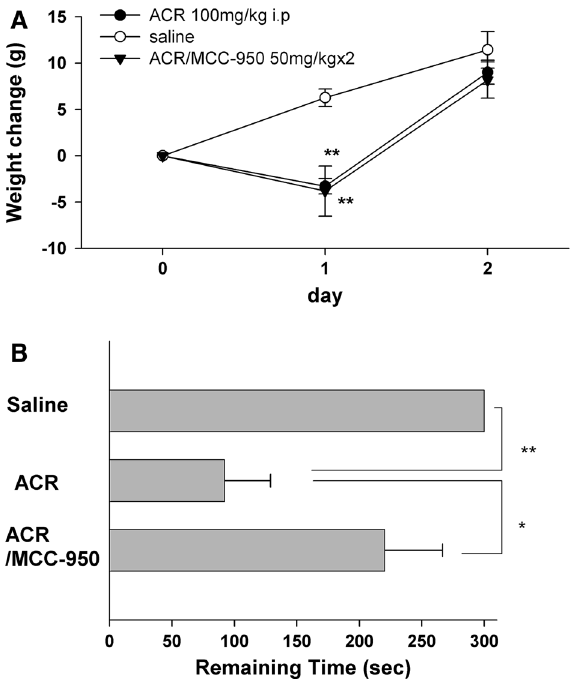
Figure 6. Effects of ACR ip injection in vivo. ( A ) In vivo administration of ACR (100 mg/kg ip) to young rats results in weight loss next day, which is compensated the following day. Injection of MCC950 (50 mg/kg, 24 h and 2 h before ACR administration) did not alter the change in weight gain. **p < 0.01 compared with control by Student t -test. ( B ) ACR administered one day prior to inhibitory avoidance training results in a defect in learning as manifest by rats more readily leaving the lit chamber to enter the dark chamber where they had received a foot shock one day previously. The learning defect was overcome by administration of MCC950. **p <